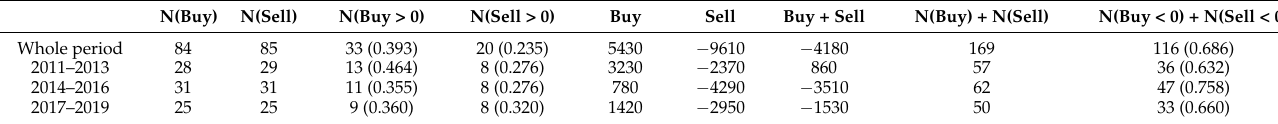
Table 1. The Performance of the Traditional MACD (12,26,9)